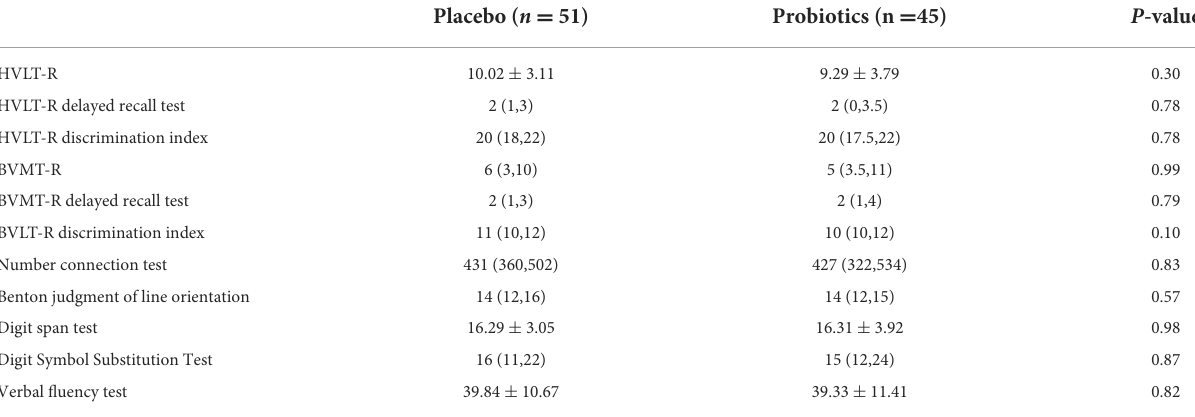
TABLE 2 Results of neuropsychological assessment at baseline.